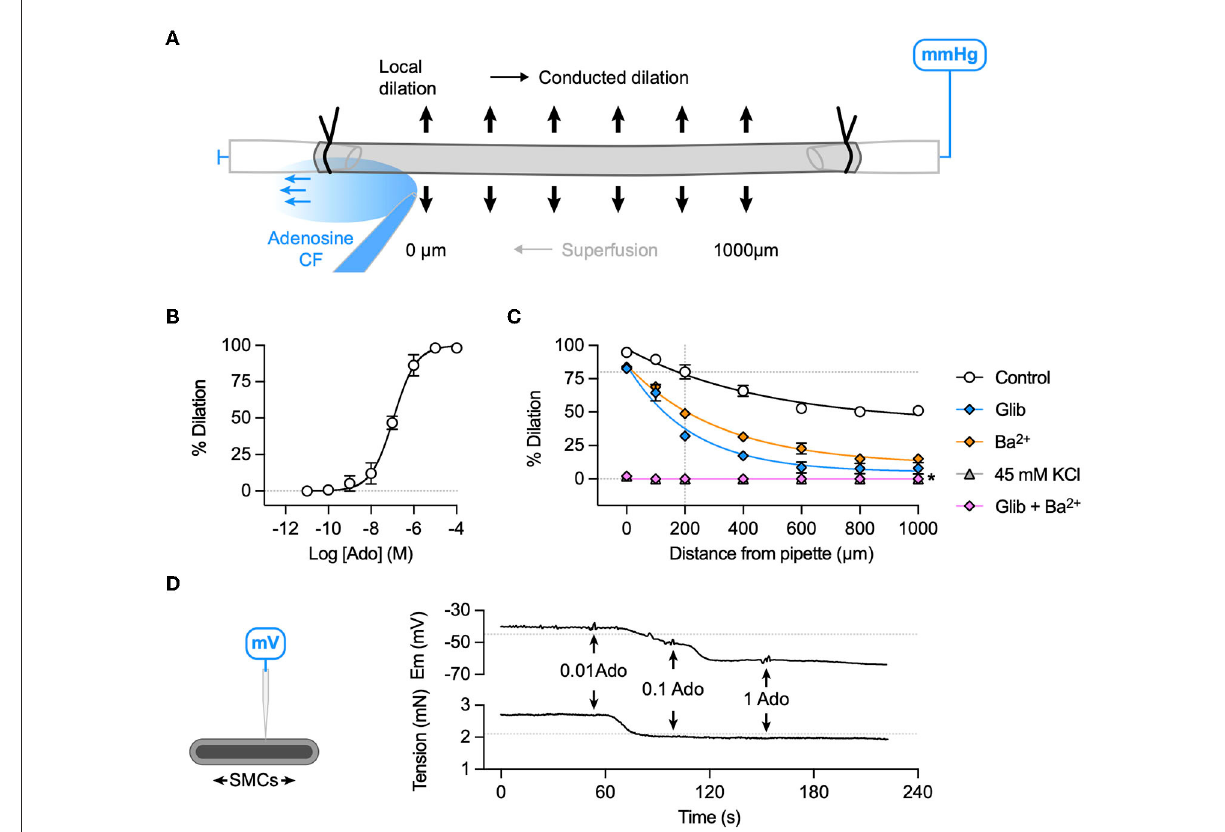
FIGURE8 K + channel-mediated vasodilation underlies conducted dilation to adenosine in porcine RA-IMCAs. (A) Schematic of experimental setup with direction of flow of adenosine (Ado) indicated by carboxyfluorescein (CF). (B) Concentration-dependent dilation to adenosine added to a static bath (log EC 50 : − 6.9; n = 3). (C) A bolus of adenosine was delivered at the point indicated by the arrow, and simultaneous inner diameter measured locally (0 µ m) and up to 1,000 µ m upstream. Summary graphs show that compared to control ( n = 5) either glibenclamide (Glib, 5 µ M, n = 5) or Ba 2 + (30 µ M, n = 3) alone reduced conducted dilation, whereas the two together or depolarization to 45mM KCl abolished conducted dilation ( n = 3, 3), respectively. For control data, simultaneous diameter measurements were made at the time when adenosine evoked 80% of maximal dilation at 200 µ m upstream from the pipette and visible CF (indicated by intersection of dashed lines). Non-parametric mixed effects analysis with Sidak’s multiple comparison test; * P < 0.05 vs. control. (D) The schematic indicates a sharp microelectrode impaled into a SMC of a porcine RA-IMCA mounted for isometric tension recording. In the presence of L-NAME, adenosine (0.01 to 1 µ M, n = 1) hyperpolarized and relaxed the artery. The resting membrane potential ( − 45.0mV) and tension (2.1 mN) prior to the addition of L-NAME (100 µ M) are indicated by dashed